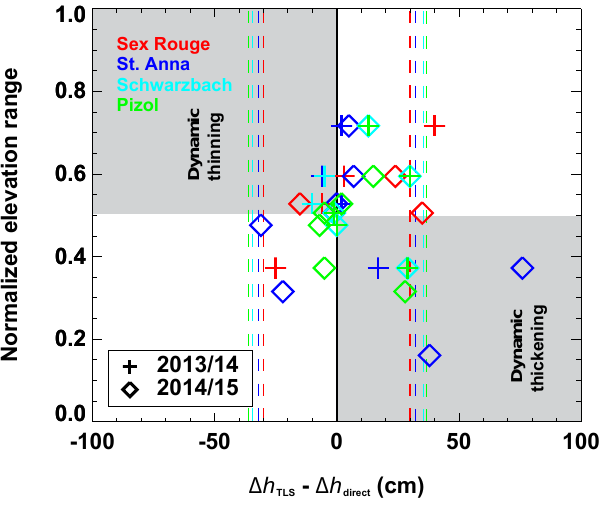
Figure 6. Differences between TLS-derived ( (cid:49)h TLS ) and observed ( (cid:49)h direct ) annual surface elevation changes at ablation stakes vs. normalized elevation range for Glacier du Sex Rouge, St. Annafirn, Schwarzbachfirn, and Pizolgletscher for 2013/14 and 2014/15. Dashed vertical lines indicate the uncertainty ranges of (cid:49)h TLS mi- nus (cid:49)h direct relative to zero. Grey quadrants mark the theoretical ranges of (cid:49)h TLS minus (cid:49)h direct vs. normalized elevation range for glaciers in